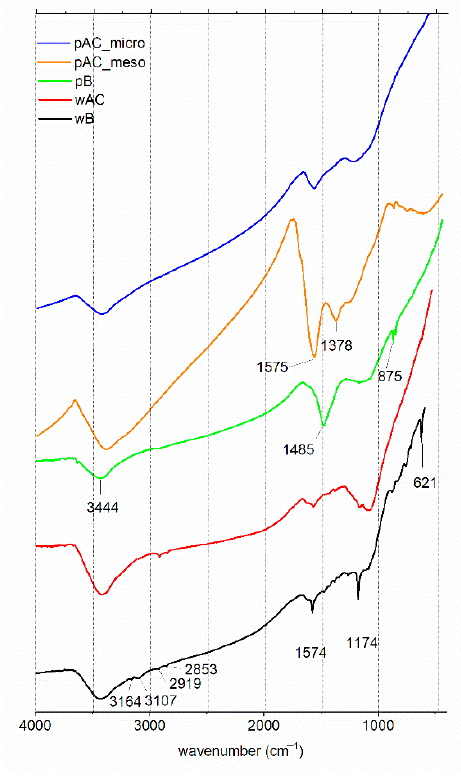
Figure 8. FT-IR spectra of the samples Figure 8. FT ‐ IR spectra of the samples indicated.